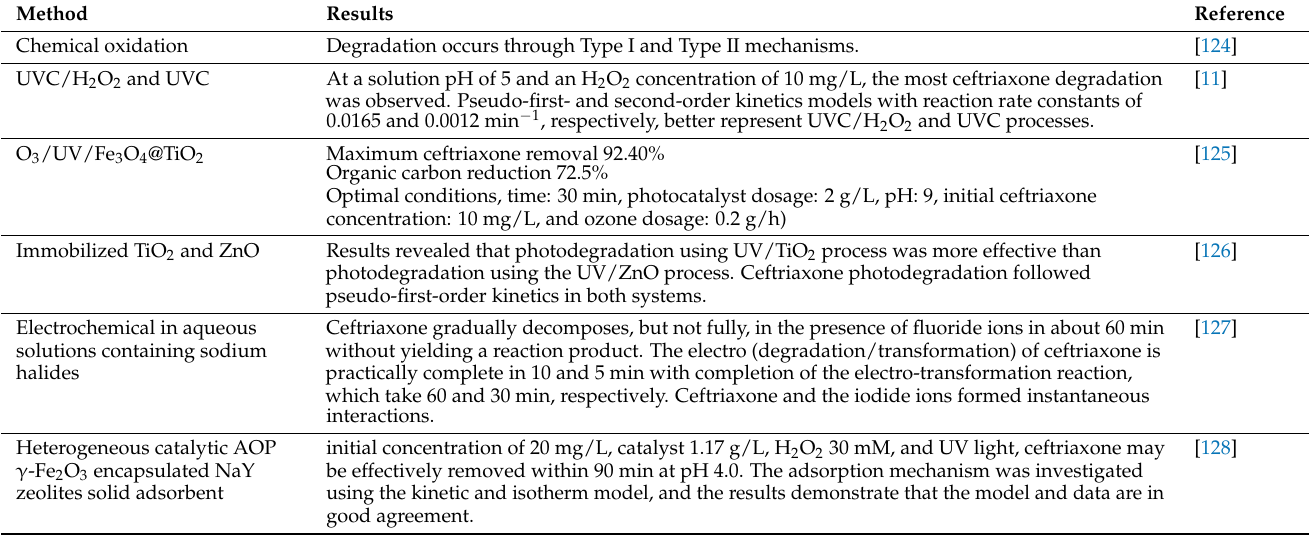
Table 3. Methods for removal of ceftriaxone from aqueous